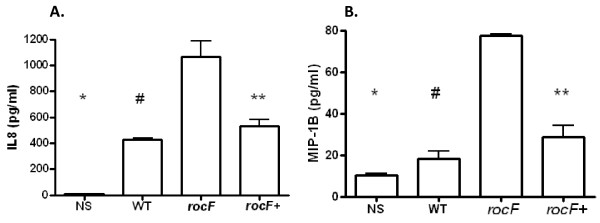
TheH. pylori rocF-mutant induces more IL-8 and MIP-1βin AGS cells than wild typeH. pylori,as determined by Bioplex. Supernatants from H. pylori infected-AGS cells were collected and used to determine the concentration of IL-8 and MIP-1β (pg/ml) A. Levels of IL-8; one-way ANOVA p < 0.0001; *p = 0.0001 (rocF- vs NS); #p = 0.0249 (rocF- vs WT); **p = 0.044 (rocF- vs rocF+); B. Levels of MIP-1B; one-way ANOVA p < 0.0001; *p < 0.0001 (rocF- vs NS); #p < 0.0001 (rocF- vs WT); p = 0.0001 (rocF- vs rocF+). Values in both Figures represent the average signal ± SEM of four independent replicates.